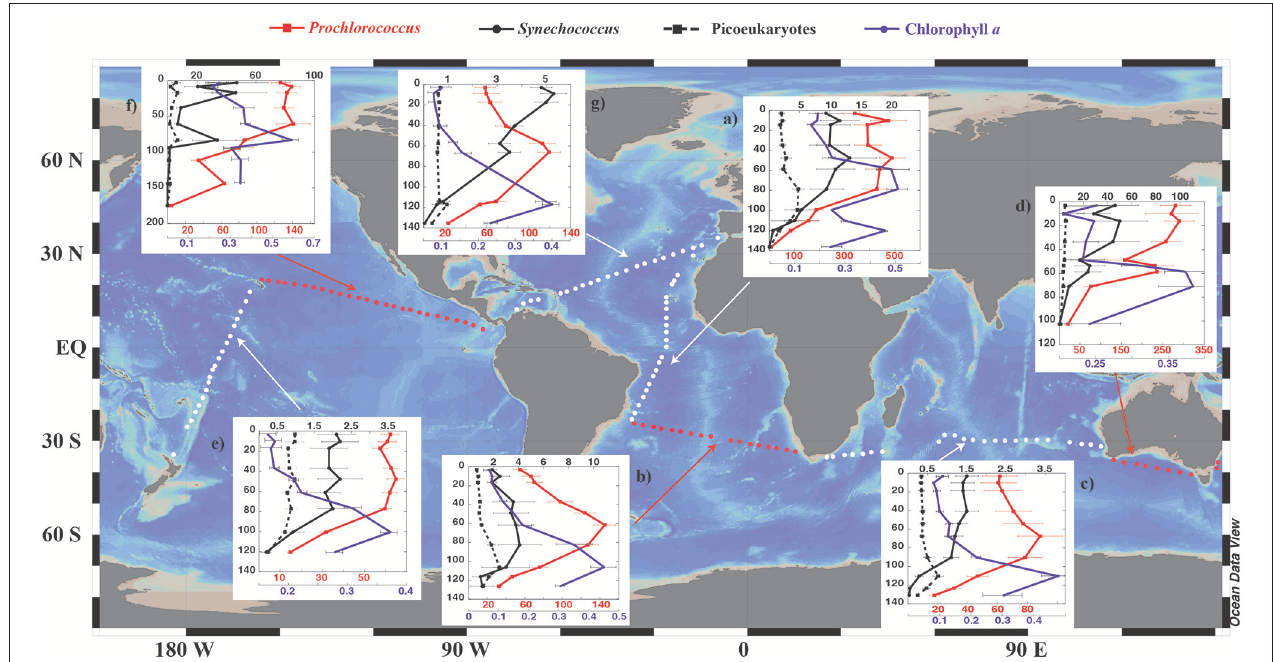
FIGURE 2 | Each panel represents the vertical distribution of autotrophic picoplankton abundances averaged for cruise sections and sampling depth (mean ± SE, × 10 3 cell ml − 1 ) across sampling stations for the different cruise legs during the Malaspina-2010 expedition: (a,b,g) legs 1, 2, and 7, Atlantic Ocean; (c) leg 3, Indian Ocean; (d) leg 4, South Australian Bight; (e) leg 5 and (f) leg 6, Pacific Ocean. The different stations sampled are traced with white and red circles along the map. White and red arrows indicate the set of stations (sections) at which each panel is referring for. Prochlorococcus (red lines and squares), Synechococcus (continuous black lines and circles), and picoeukaryotes (dashed black lines and squares). Chlorophyll a vertical distribution for each sampling leg and depth (mean ± SE, µ g l − 1 , purple lines and circles) is also shown in each panel. The purple and red colors of the X axis correspond to the chlorophyll a and picophytoplankton values,